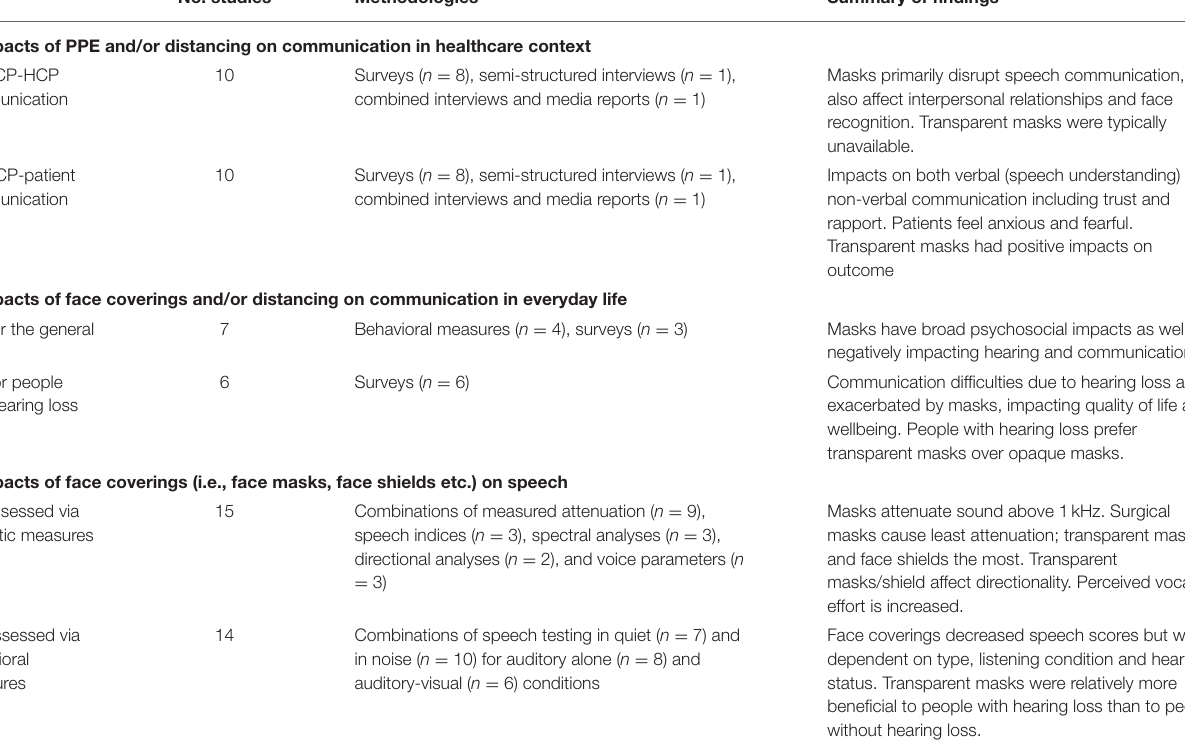
TABLE 1 | Summary of studies on the impact of COVID-19 preventative measures on communication included in scoping review ( n = 50) according to study subcategory. No.